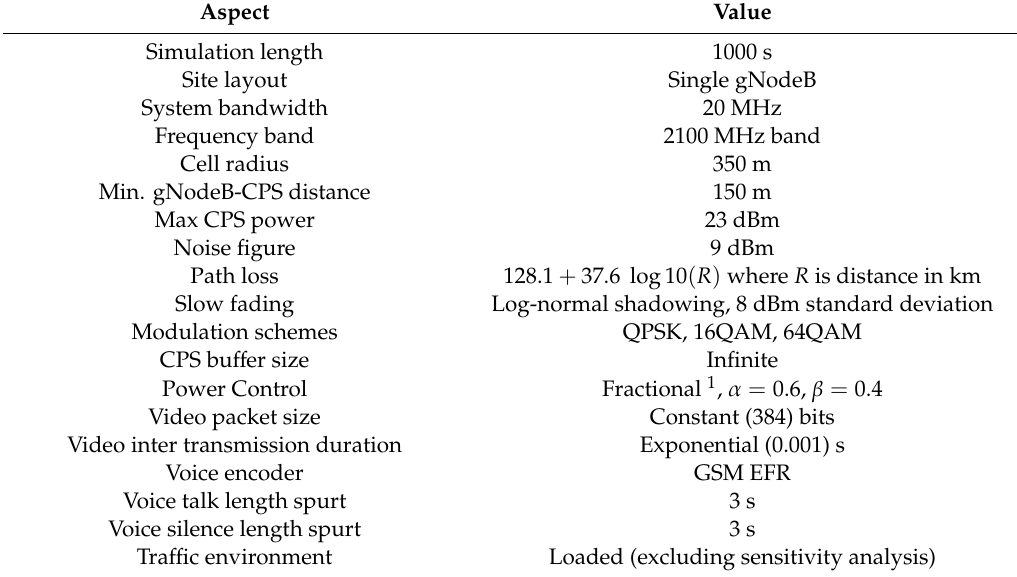
Table 1. Simulation aspects and assigned